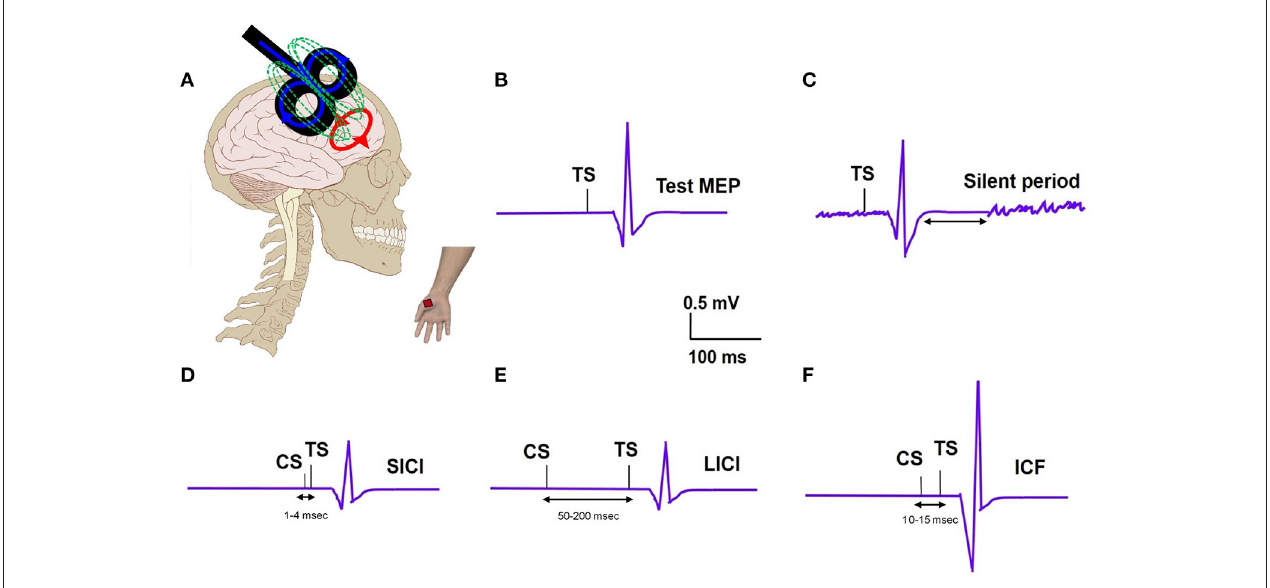
FIGURE 1 | (A) TMS set up: TMS coil applied to the motor cortex and motor evoked potential (MEP) recording from the distal hand muscle; electric field (blue); magnetic field (green); induced electric field (red). (B) Test MEP: MEP elicited with a test stimulus (TS). (C) Silent period: Recording of EMG silence that occurs after the MEP when a suprathreshold TMS pulse is delivered during active muscle contraction. (D) Short interval intracortical inhibition (SICI); MEP elicited with TS is inhibited when preceded by a subthreshold conditioning stimulus (CS) at a short interval of 2–3ms. (E) Long interval intracortical inhibition (LICI); MEP elicited with TS is inhibited when preceded by a suprathreshold CS at a long interval (100ms). (F) Intracortical facilitation (ICF); MEP elicited with TS is increased when preceded by a subthreshold CS at an interval of 10–15